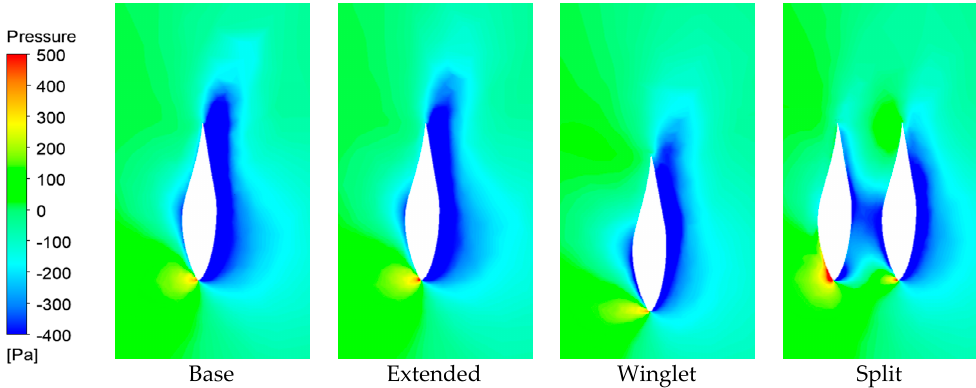
Split Figure 9. Pressure contour at the rotor blade tip at V = 11 m/s.